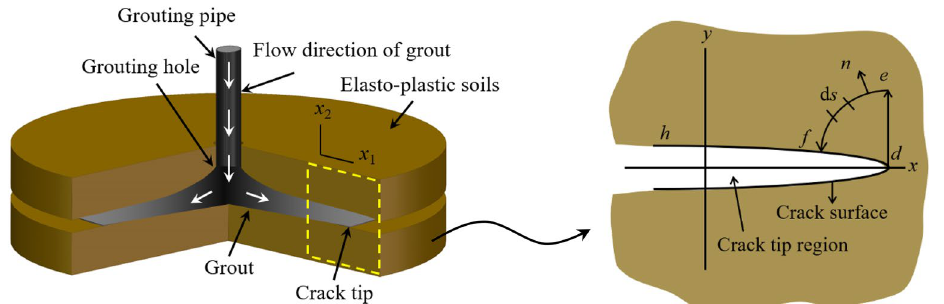
Figure 3. Integration path and K-dominant